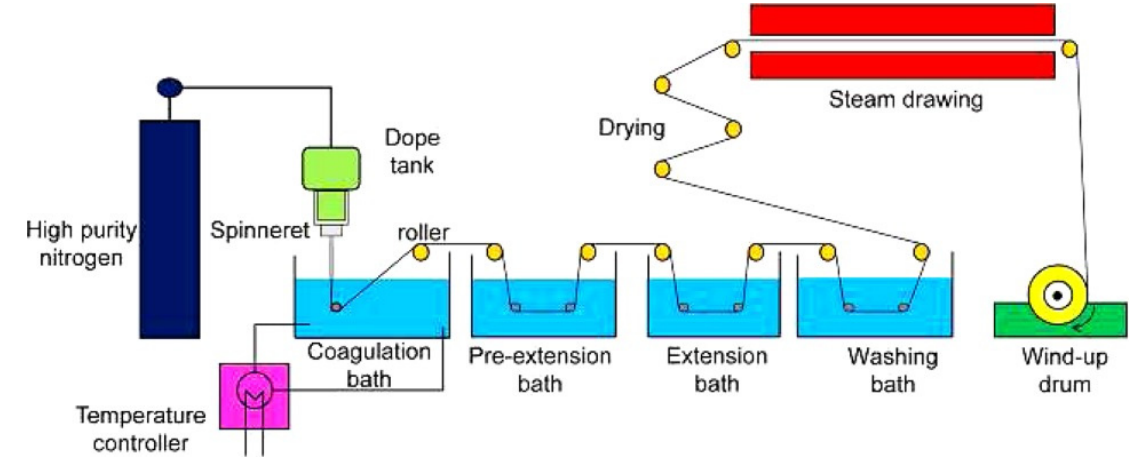
Figure 8. Schematic of the dry-jet wet spinning line (reprinted with permission from [76] , copyright 2014 John Wiley and Sons).